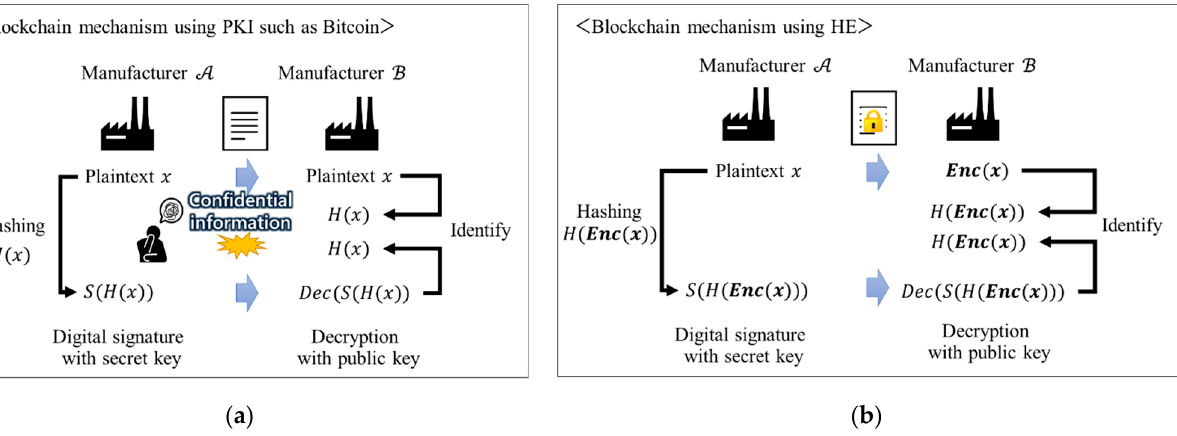
Figure 1. The issue of BC utilization and the secure approach in B2B collaboration. ( a ) Issue of BC utilization; ( b ) Secure approach in B2B collaboration.